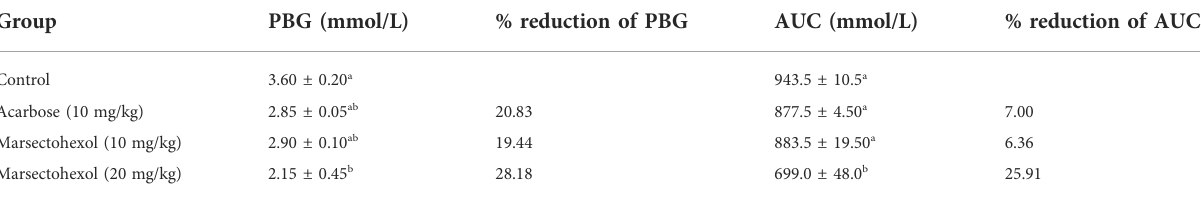
TABLE 3 Effect of acarbose and the marsectohexol on blood glucose level in albino rats. Group